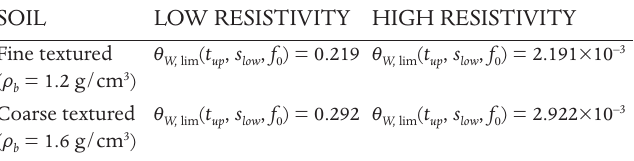
= 1 ppt). Overlap of the present low ( t , s , f , f ) of water as a W up low 0 ( t , s , f , f ) as a function of W up low 0 ( t , s , f ) for fine or coarse W, lim up low 0